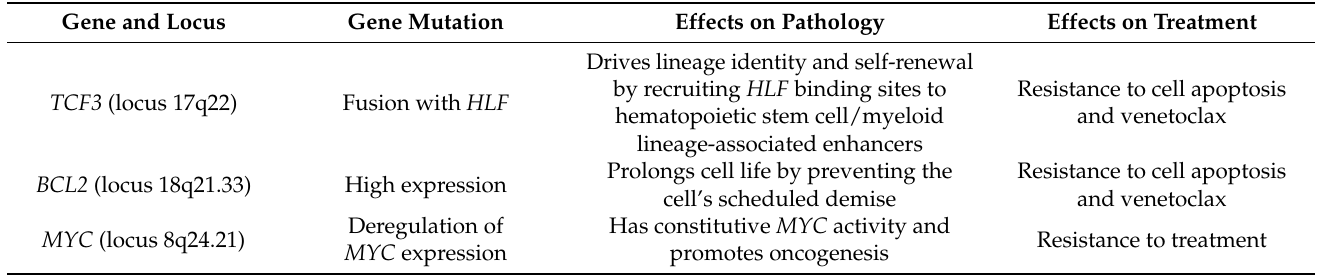
Table 5. Characteristics of genes, mutations, and their effect on treatment present in patients with a TCF3 :: HLF